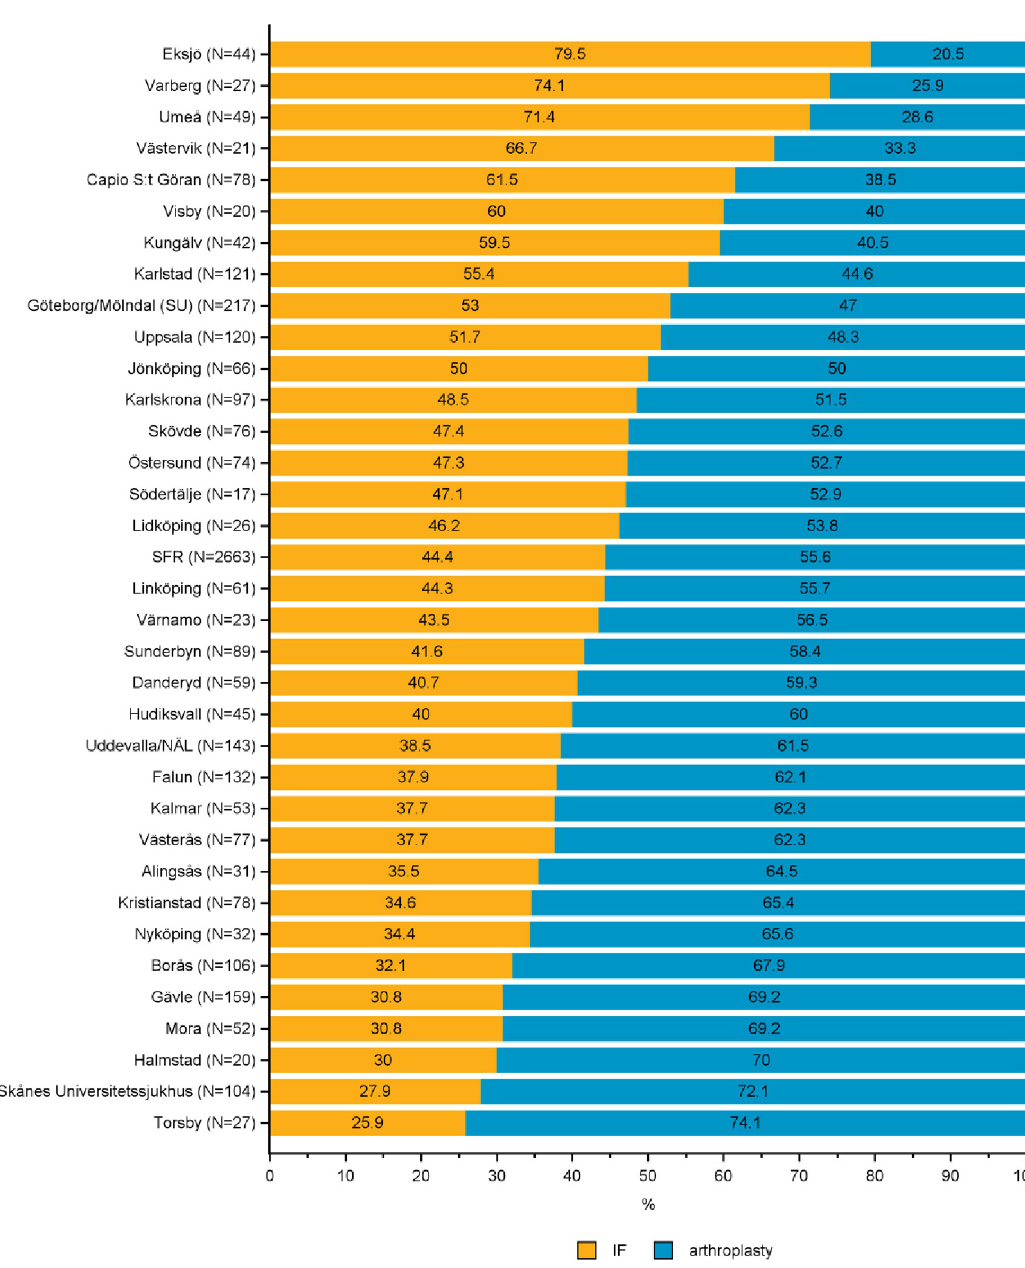
Fig 6. Distribution of internal fixation (IF) and arthroplasty in the treatment of B2 basicervical fractures by department in the Swedish Fracture Register in 2016–2020. SFR denotes all registrations in the Swedish Fracture Register (distributions are nationwide